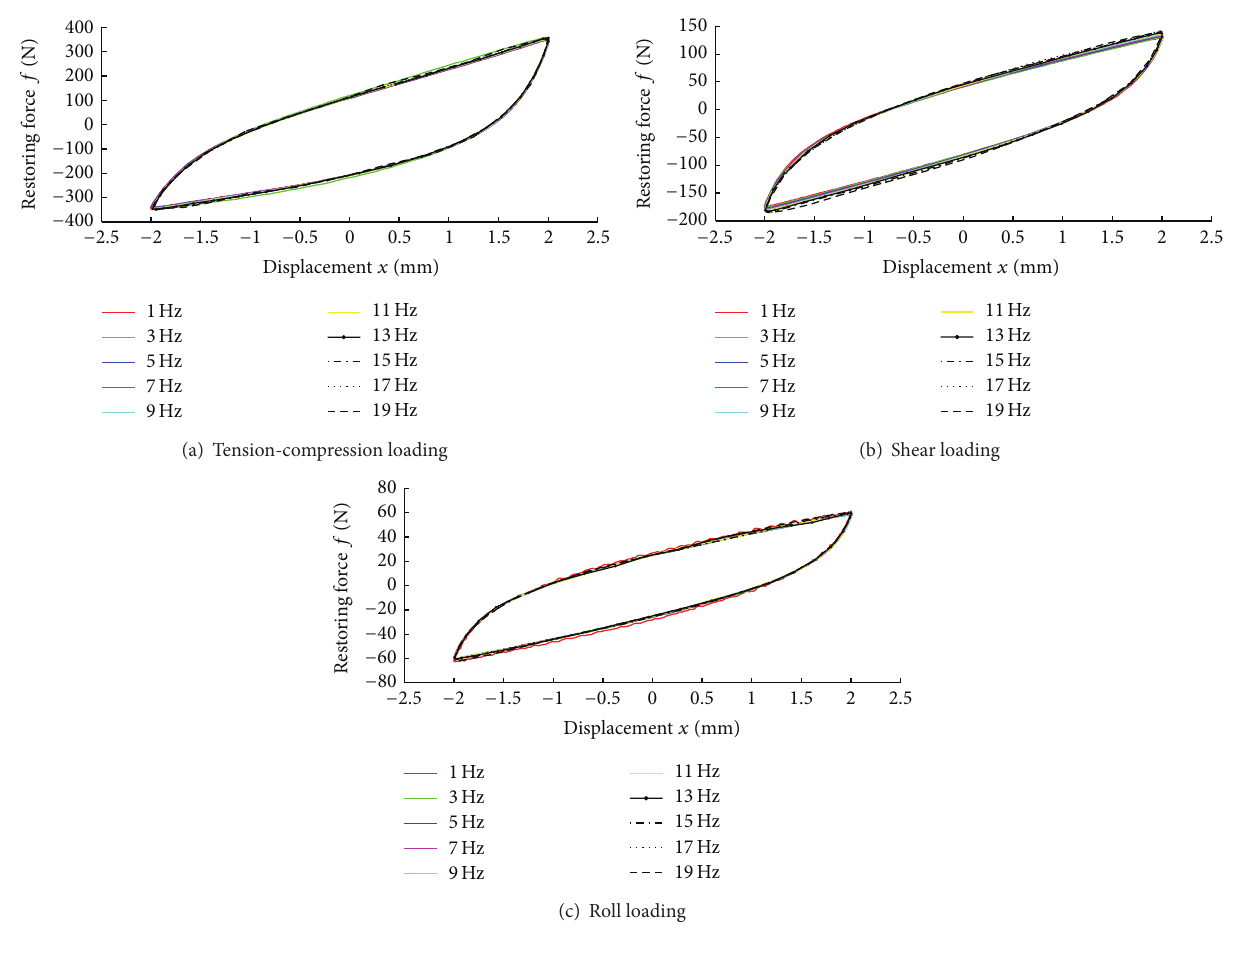
Figure 4: Experimental hysteresis loops with different